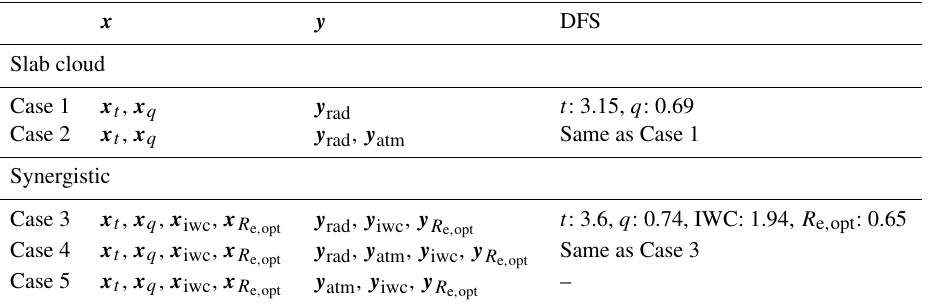
Table 1. State vector and observation vector in four retrieval strategy cases. Case 5 is a posterior estimation of the state vector from a combination of y atm , y iwc , y R , and the a priori profile. DFS is compared to the number of vertical layers of the state vector. DFS is e , opt counted from 130 to 13.5hPa for temperature and water vapor (20 model layers).